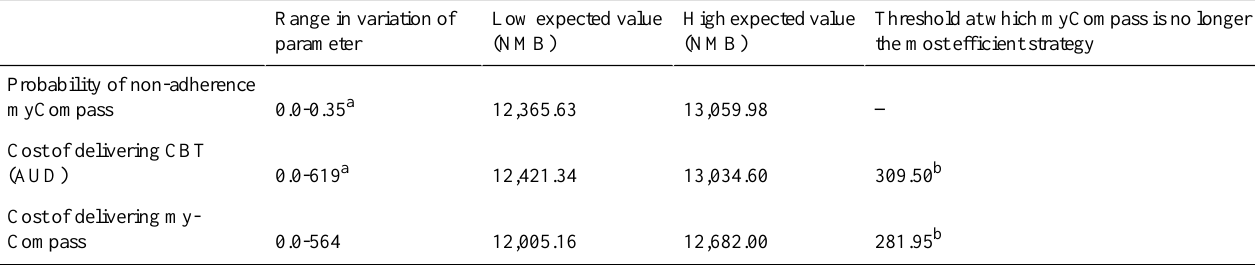
Threshold at which myCompass is no